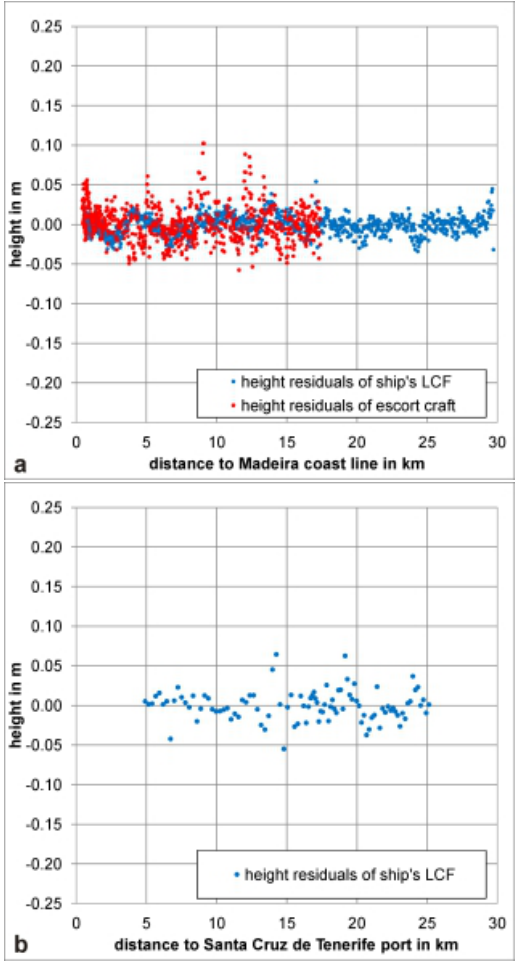
Figure 18. HeightresidualsofLCFandescortcraft’sARPatMadeira (a) and LCF height at Tenerife (b) from common adjust- ment.